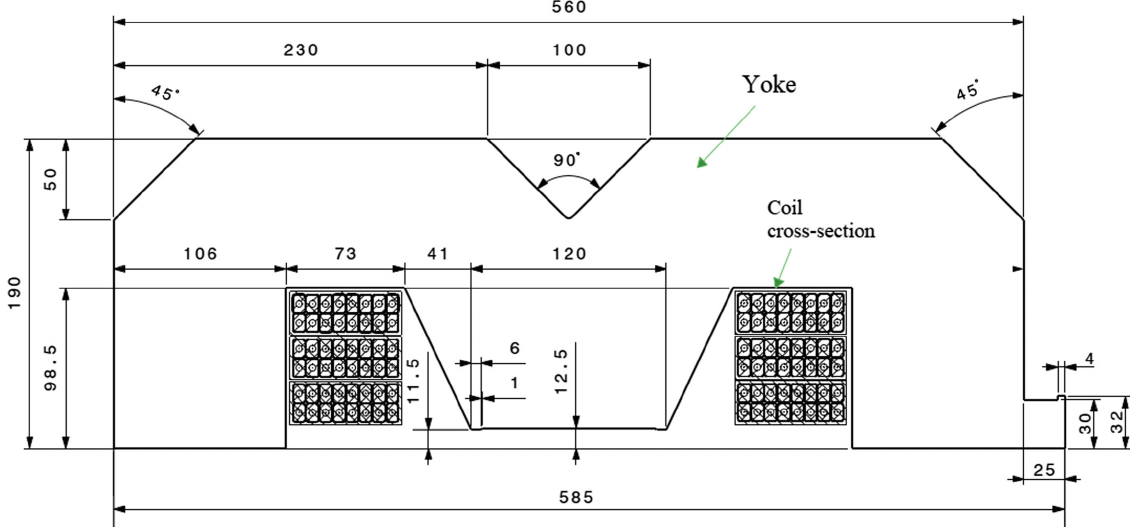
FIG. 6. Cross section of the H type dipole magnet.